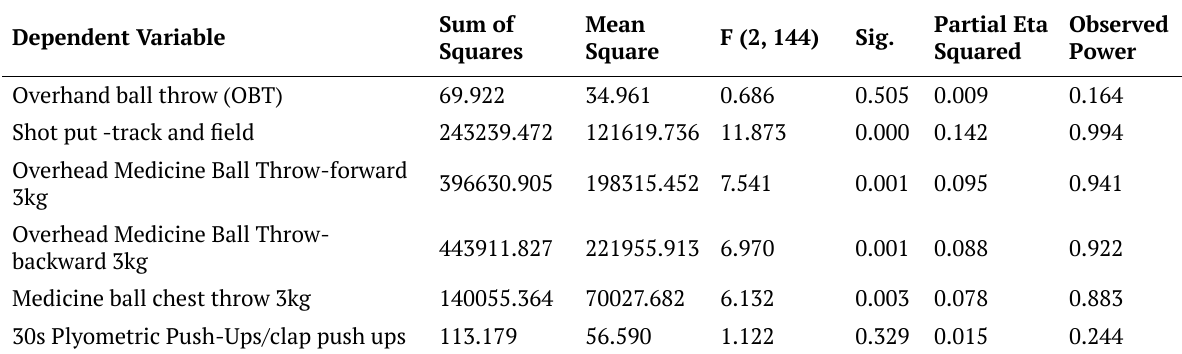
Table 4. Univariate test results (ANOVA) – The effect of variable BMI levels on the performances in upper body strength